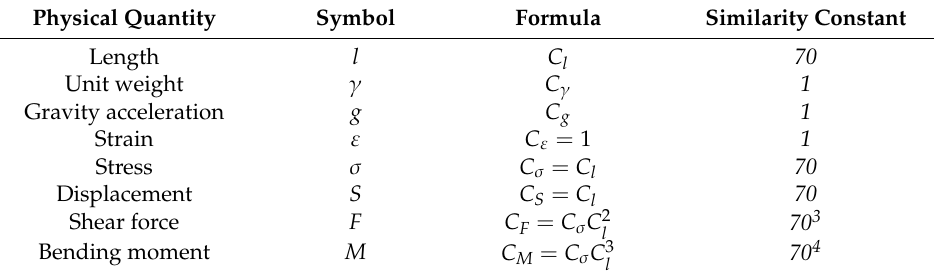
Table 4. Similarity constants of bridge pile foundation and anti-slide piles.